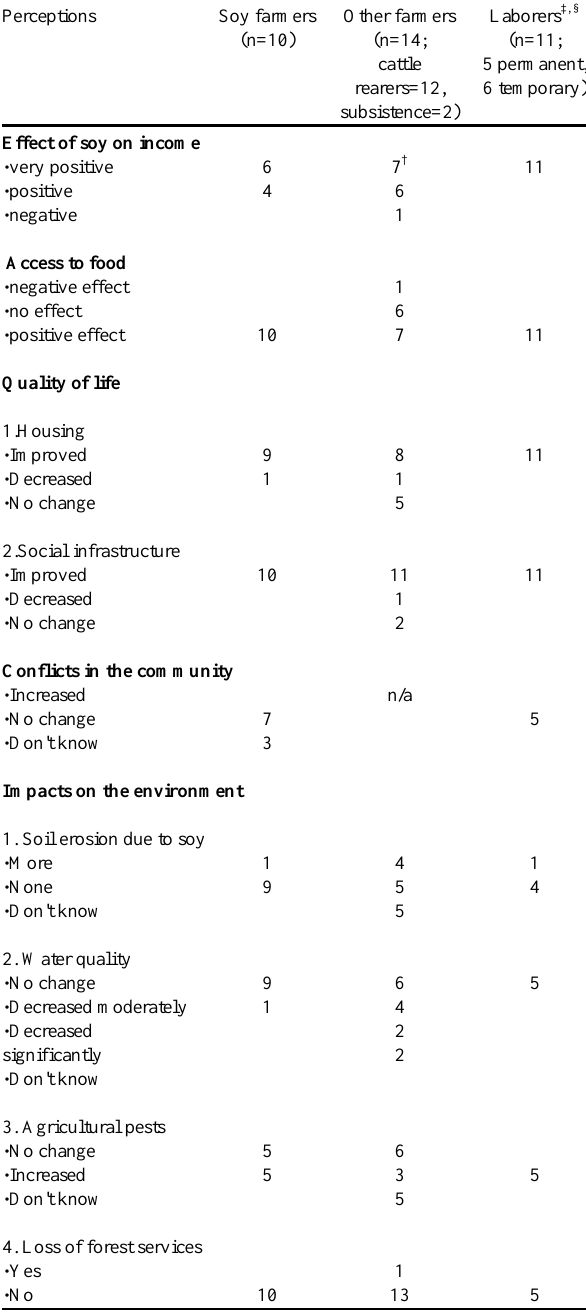
Table 3 . Perspectives of soy farmers, other farmers and laborers on impacts of soy Perceptions Soy farmers